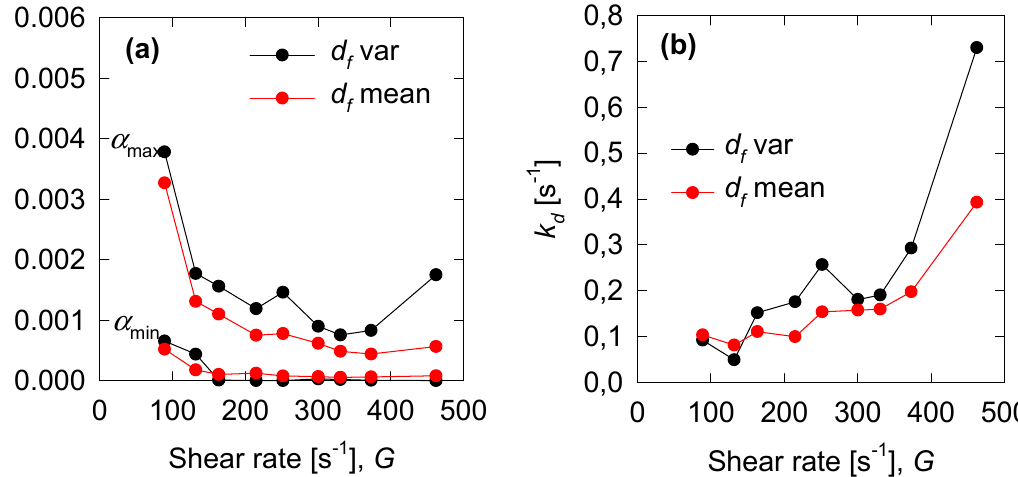
Figure 6. Optimum aggregation parameters vs. shear rate for constant and variable fractal dimension, ( a ) maximum and minimum collision efficiencies and ( b ) collision efficiency decay constant 𝑘 (cid:3031) .